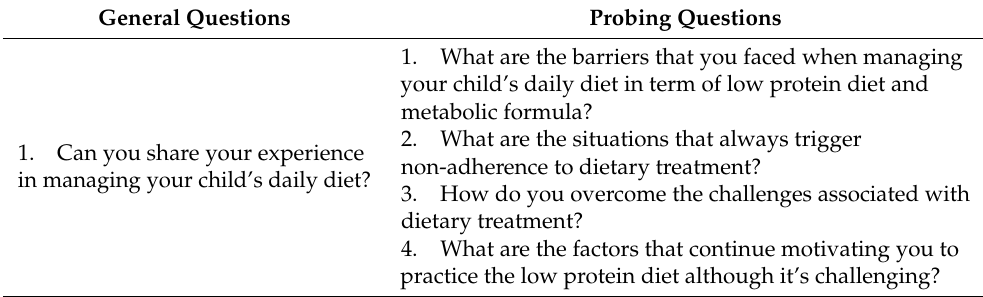
Table 1. Focus group discussion